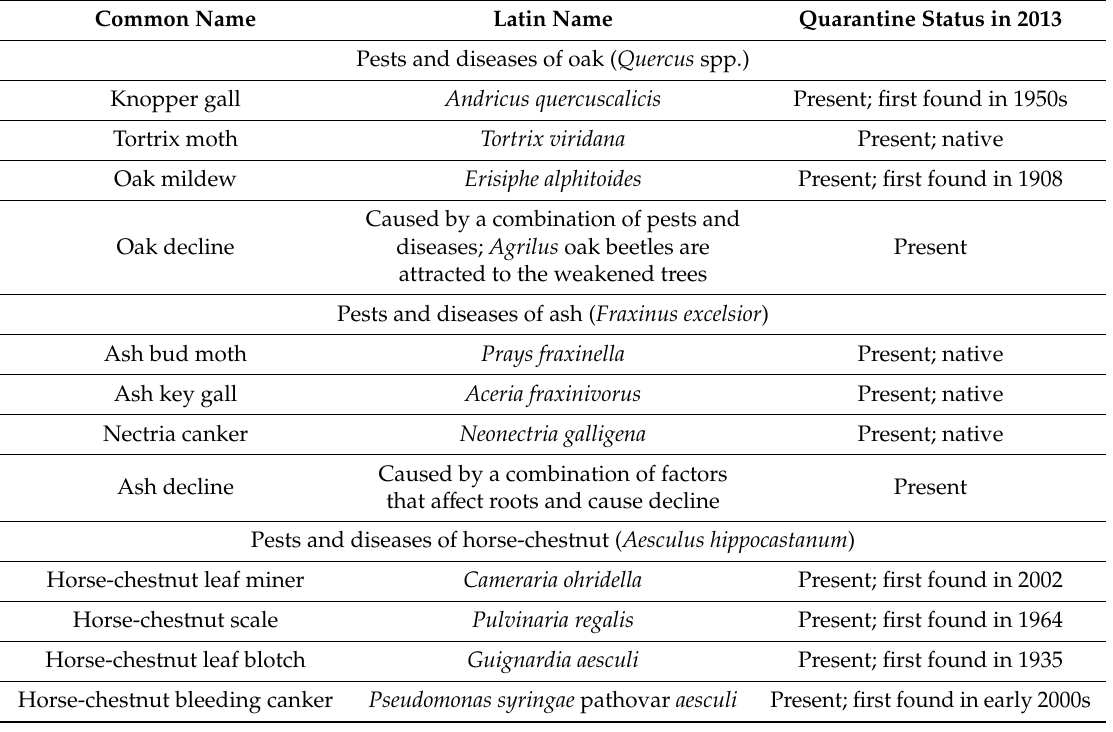
Table 2. Pests included in survey to provide information on their latest distribution.”